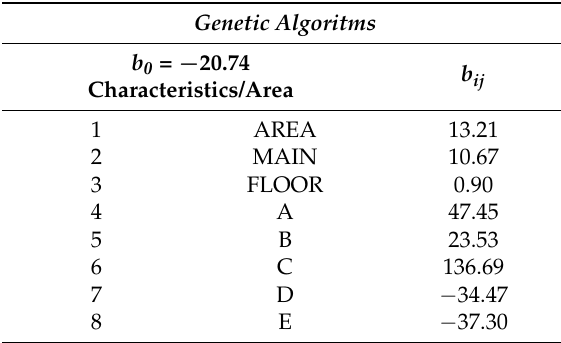
Table 2. Results of GA